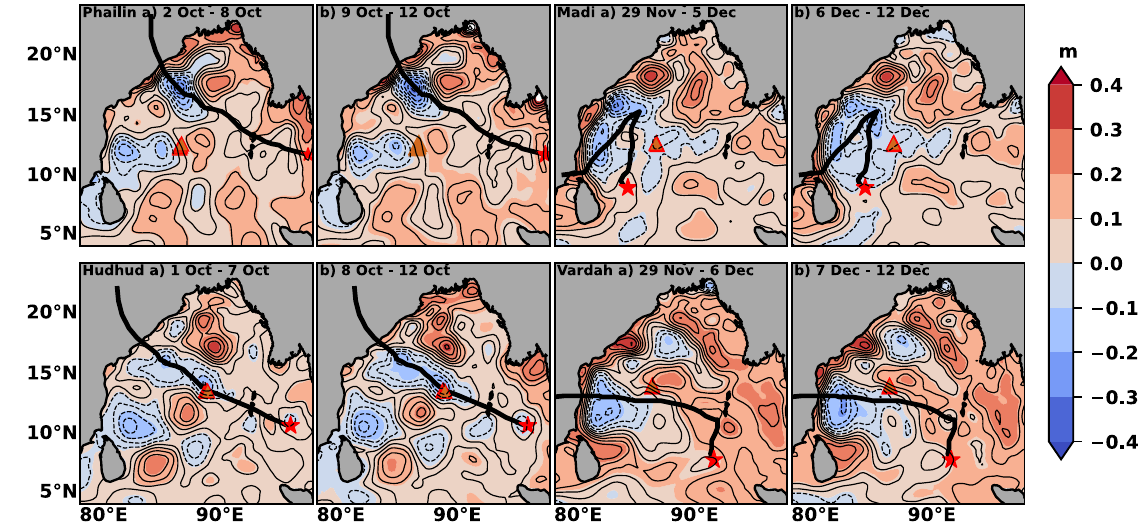
Fig. 5 Eddies and primary productivity. The 7-day composite of sea level anomaly (m) before and during the cyclones in BoB. The black solid lines represent the cyclone tracks, the stars represent the genesis location of the cyclone and the box represents the Argo fl oat